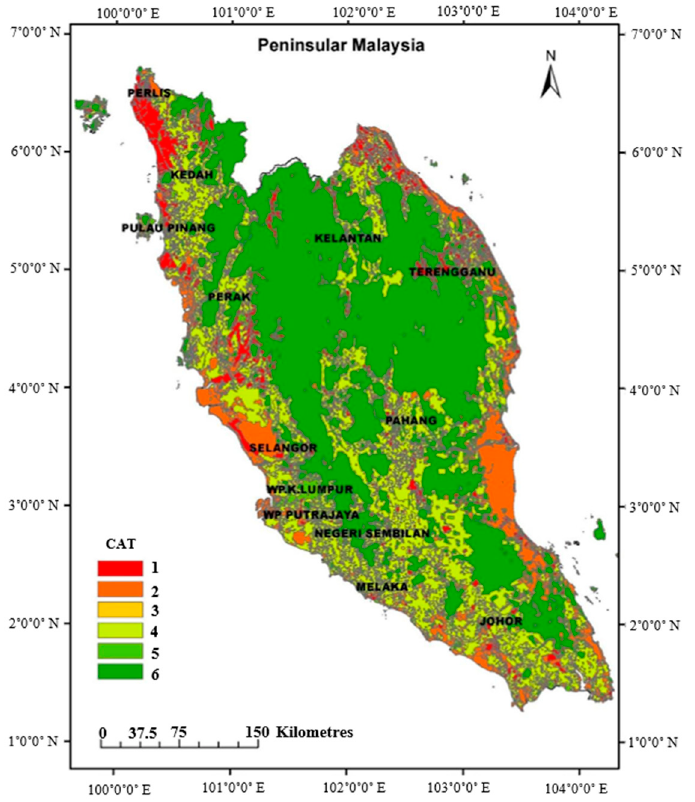
Figure 6. LULC based on the terrain category.